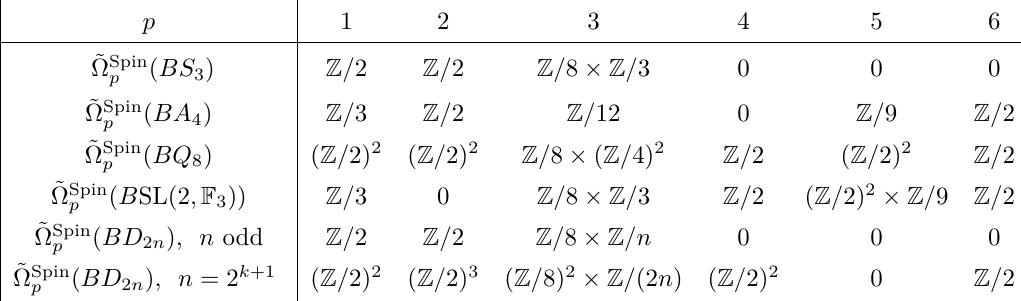
Table 1. Reduced spin-bordism groups in degrees 1 through 6 of BG , for various finite non- abelian groups G . The full (i.e. unreduced) spin bordism groups are obtained as Ω Spin ˜Ω Spin ( BG ) ⊕ Ω Spin (pt) p p